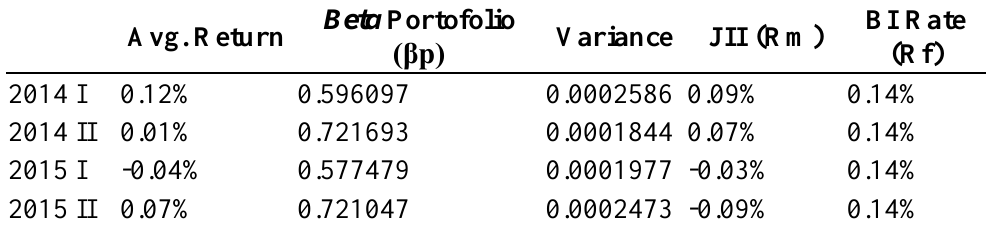
Table 10 Average Return. Beta, Variance Portfolio, Average Index,